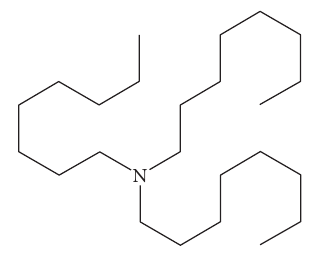
Figure 5: Tri-n-octylamine structure